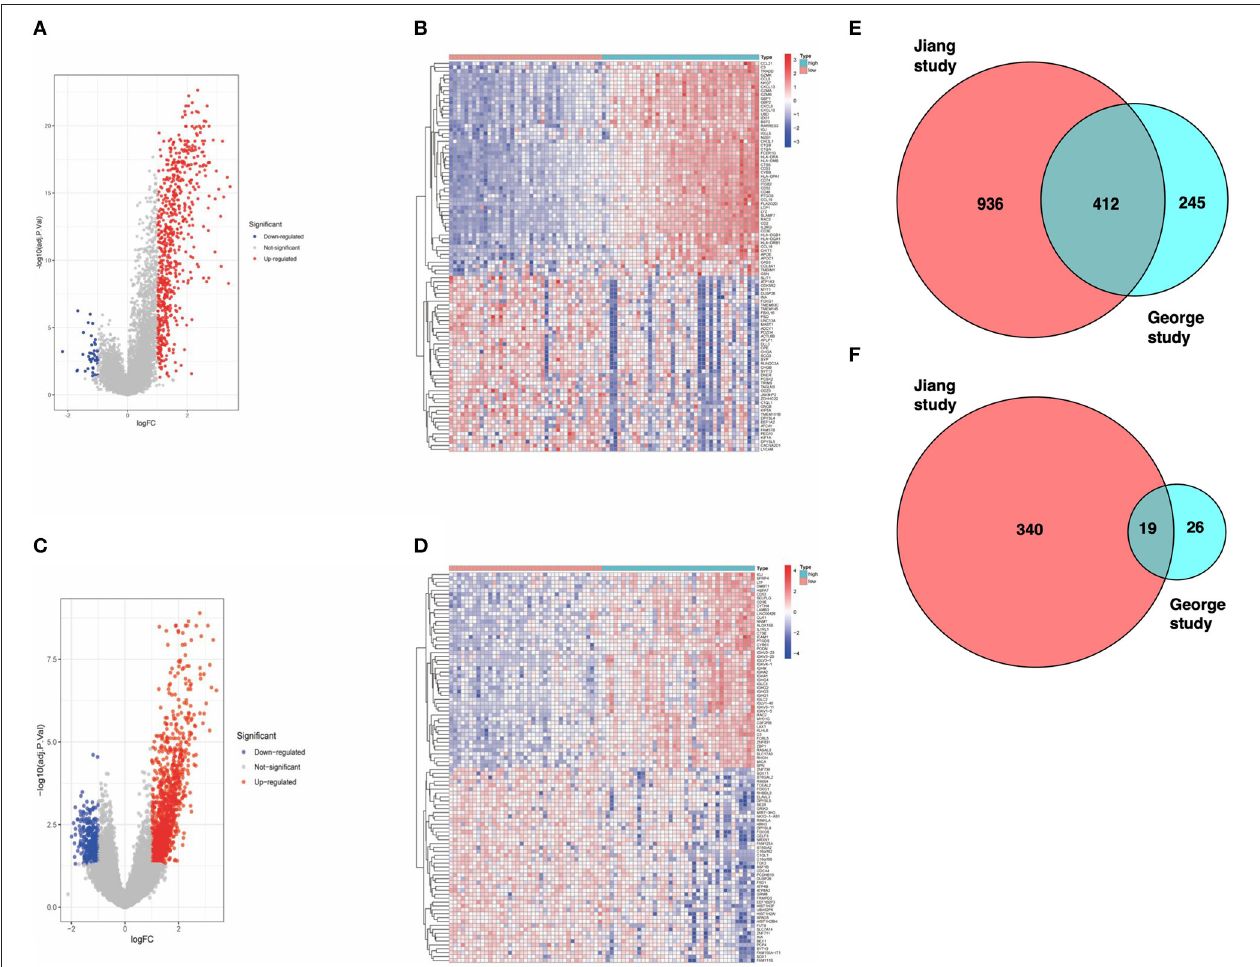
FIGURE 1 | (A) Volcano map of dataset from the George cohort (Red dots represent upregulated genes, blue dots represent downregulated genes, and gray dots indicate no difference in expression). (B) Heat map of the DEGs identified from the George cohort. (C) Volcano map of the Jiang cohort. (D) Heat map of DEGs identified from the Jiang cohort. (E) Venn diagram. The intersection represents the upregulated genes in the high-score cohort of both datasets. (F) Venn diagram. The intersection represents the downregulated genes in the high-score cohort of both datasets.